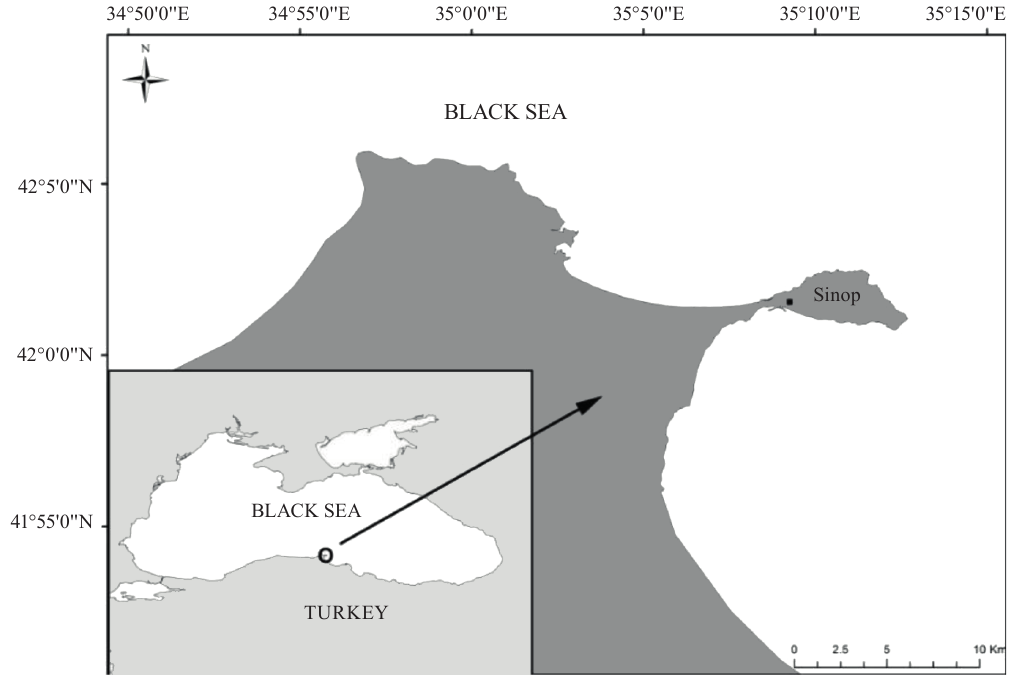
Figure 1 Fishing